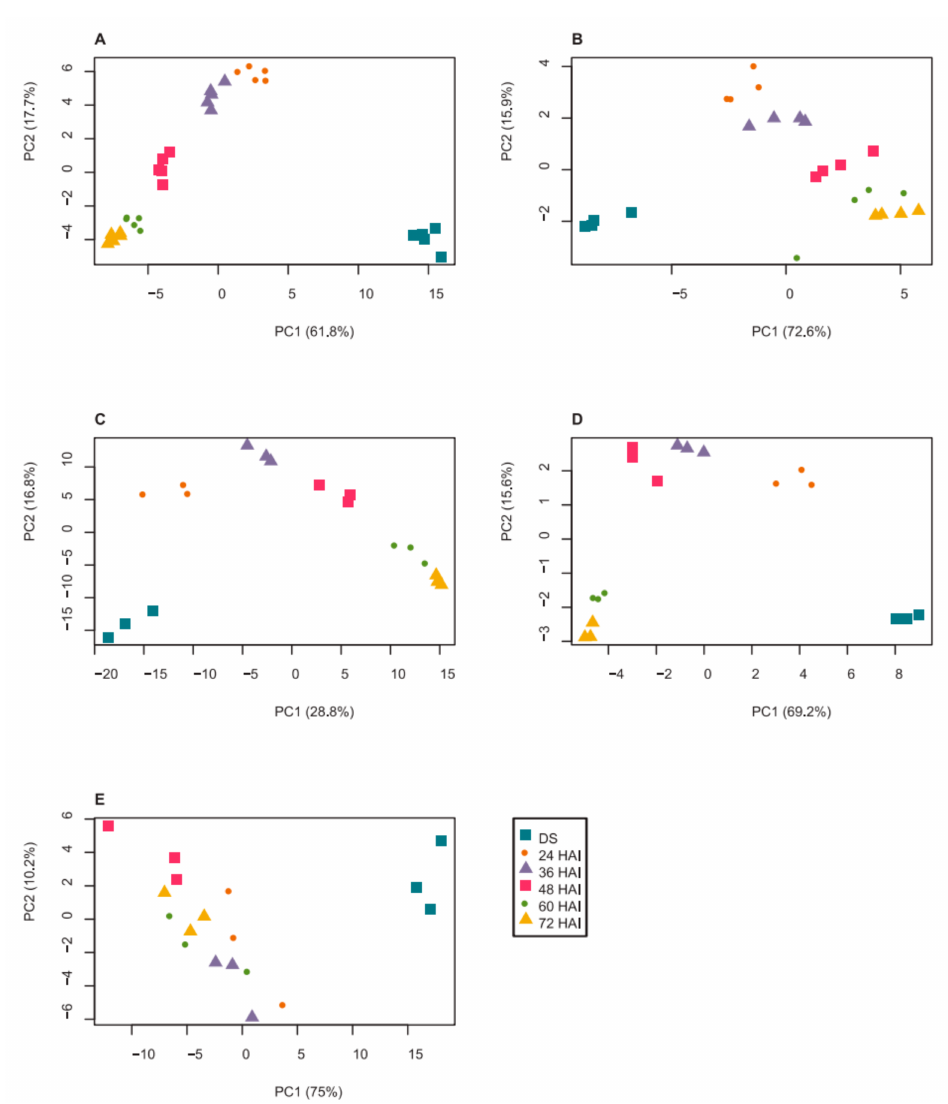
Figure 1. PCA of ( A ) metabolites, ( B ) amino acid composition, ( C ) heat-stable proteome, ( D ) LEA proteins and ( E ) expression of genes encoding LEA proteins of dry seeds (DS), germinating seeds and seedlings at different hours after imbibition (HAI). Data are log 2 -transformed, median-normalized mass spectral intensities ( n = 5) ( A ), concentration of amino acid (nmol/gDW) after log 2 transforma- tion and median normalization ( n = 4) ( B ), mass spectral label-free quantification (LFQ) intensities after log 2 transformation and median normalization ( n = 3) ( C , D ) or DW-normalized absolute tran- script copy number in log 2 with median normalization ( n = 3) ( E ). Missing values were replaced with 0 prior to the analysis. Samples at different HAI are as indicated by the